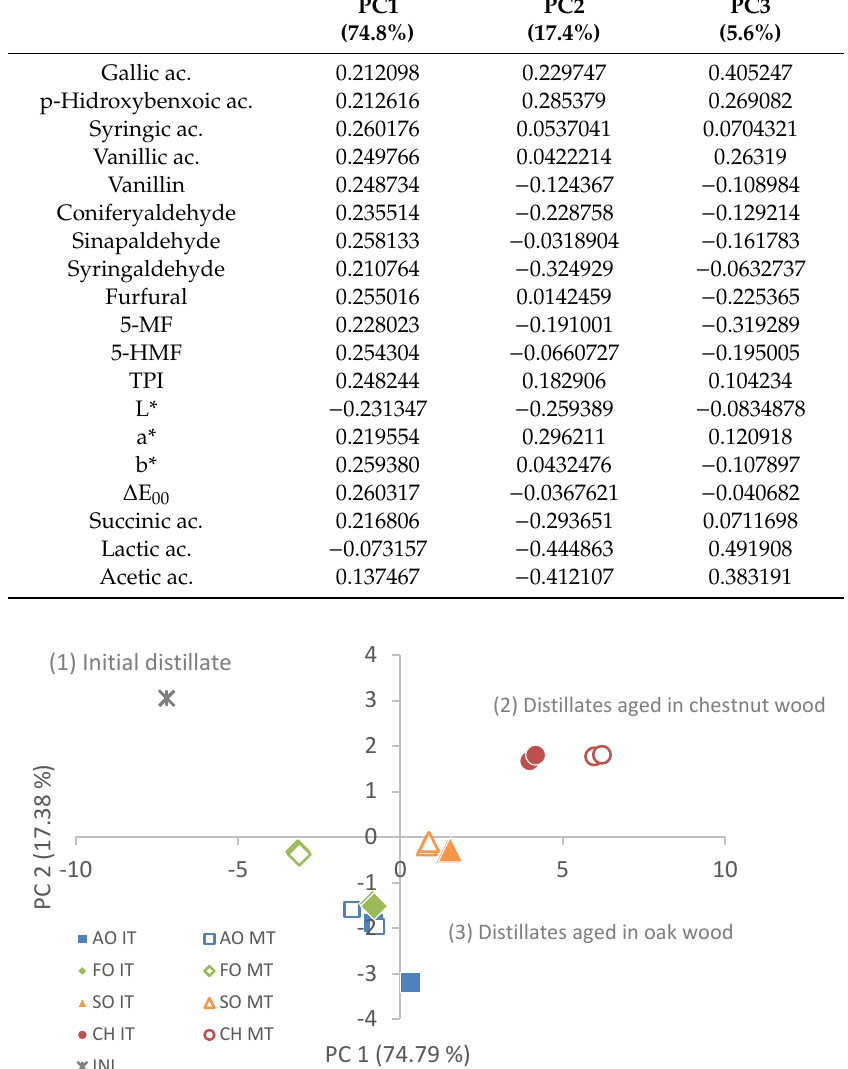
Figure 3. Biplots of vector loadings and distribution of samples for Principal Component analysis (PCA) according to the type of barrel and toast used. PC1 versus PC2. Table 5. Weights of the variables for each Principal Component of PCA.